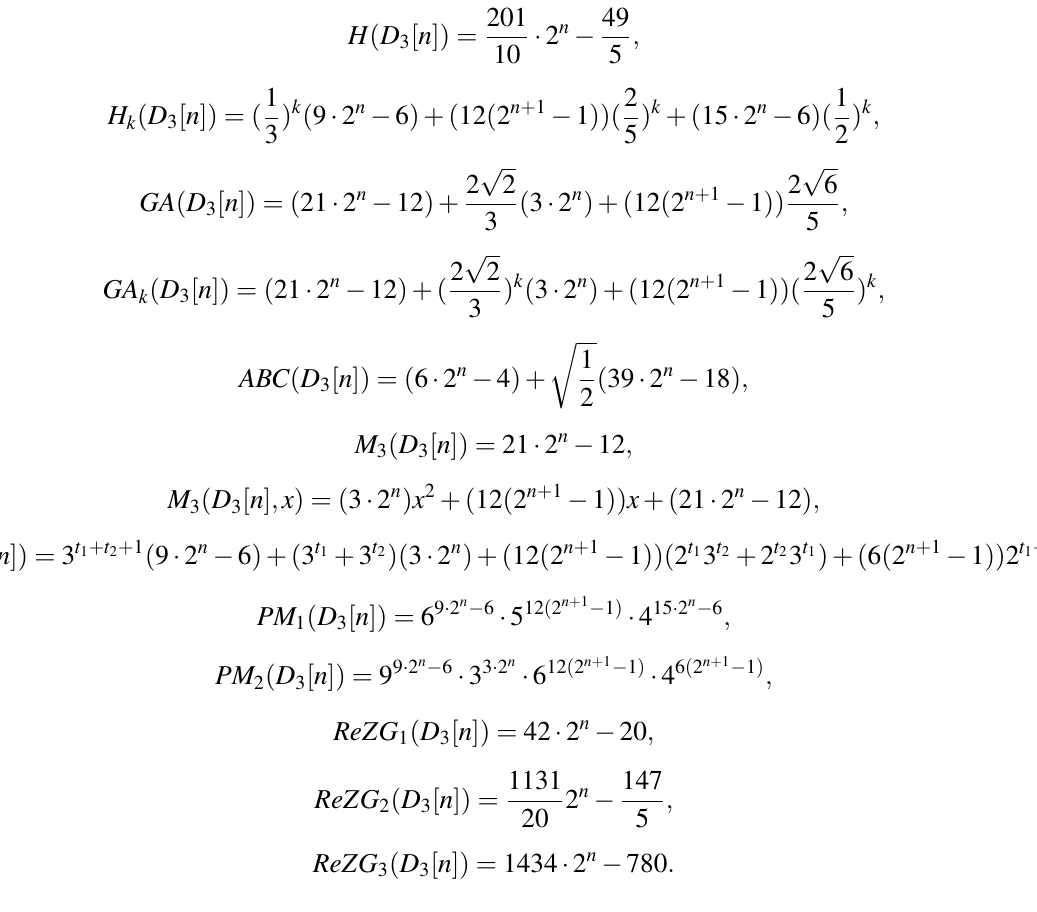
Fig. 10 Classes of inlets occurring on the perimeter of a benzenoid